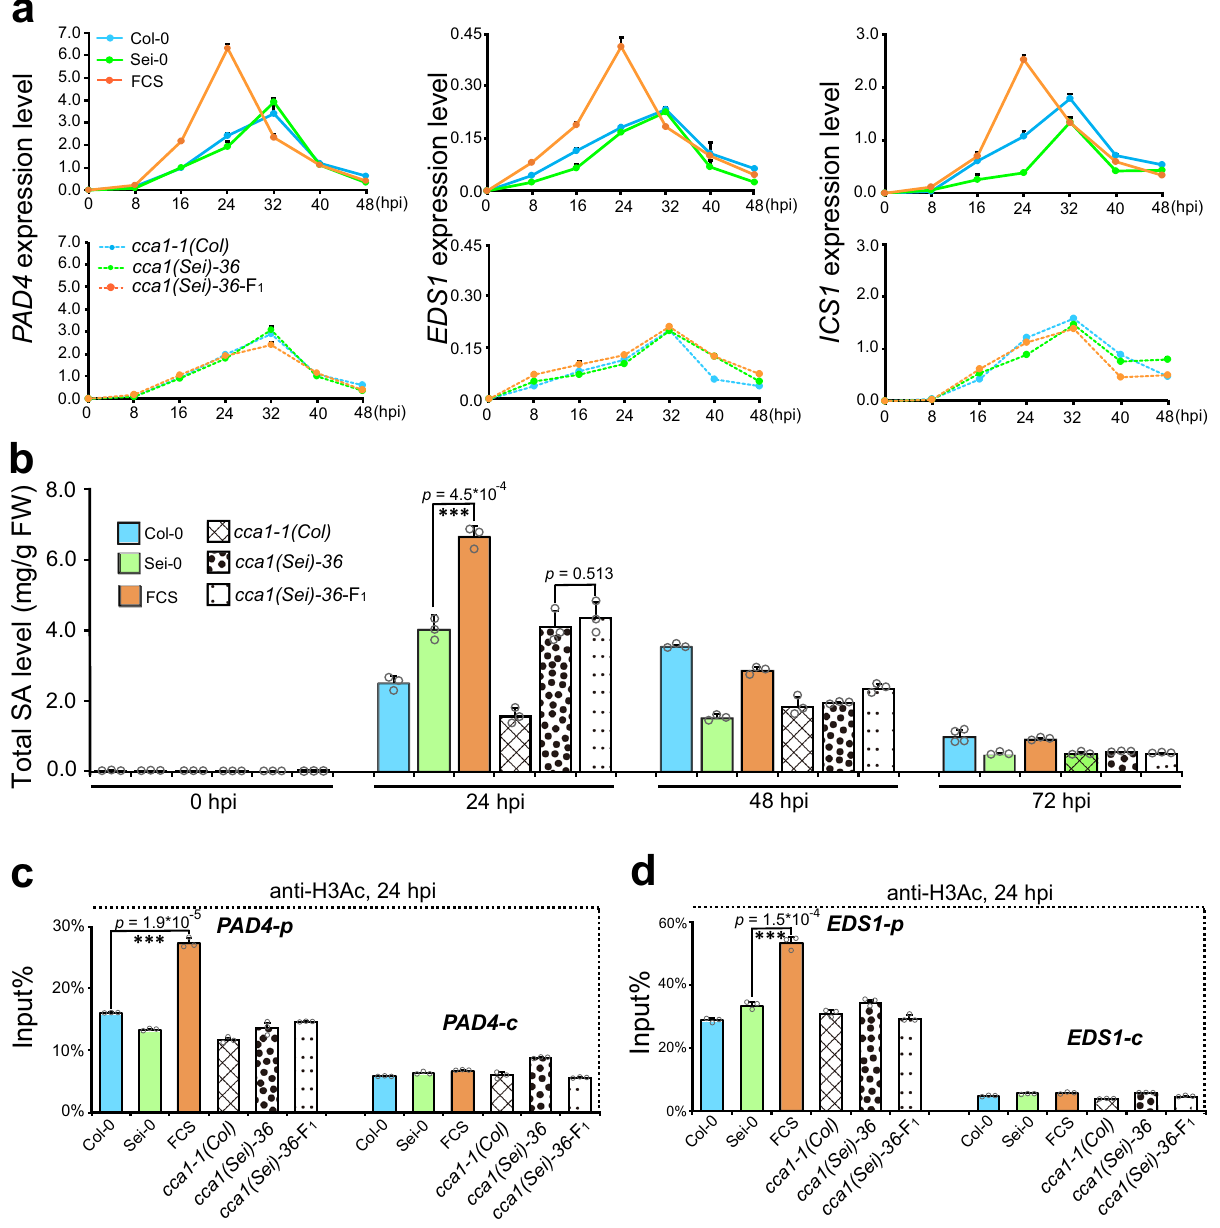
Fig. 2 CCA1 confers defense heterosis by enhancing salicylic acid biosynthesis in hybrids. a qPCR analyses of the expression level of PAD4 , EDS1 , and ICS1 in Col-0 × Sei-0 and CCA1 -mutated F fi ltration (hpi) up to 48 hpi. Data are standardized for the abundance of the 1 hybrids and parents every 8 h post in ACTIN2 transcript. Data are shown as the mean ± SD ( n = 3, n indicates biological replicates). b Total SA level in Col-0 × Sei-0 and CCA1 -mutated F 1 hybrids and parents at 0, 24, 48, and 72 hpi with Pst DC3000 inoculation. Data are shown as the mean ± SD ( n = 4, n indicates biological replicates). SA salicylic acid. ChIP-qPCR analyses of promoter fragments ( PAD4-p and EDS1-p ) and exon fragments ( PAD4-c and EDS1-c ) of PAD4 ( c ) and EDS1 ( d ) in Col-0 × Sei-0 and CCA1 -mutated F 1 hybrids and parents using an anti-H3Ac antibody at 24 hpi. ChIP values were normalized to their respective DNA inputs. The results are representative of three biological replicates, with measurements taken from independent samples grown and processed at different times. Data are shown as the mean ± SD ( n = 3, n indicates biological replicates). *** p value < 0.001 (two-tailed Student ’ s t